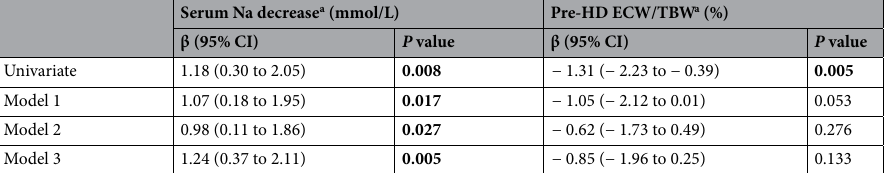
Table 3. Association of serum Na decrease (mmol/L) and pre-HD ECW/TBW (%) with SBP decrease index (%) in mixed linear regression. Model 1 is adjusted for: K decrease, urea decrease, pre-HD glucose, age, square of age, gender, ethnicity, BMI, diabetes, antihypertensive medication, coronary artery disease and congestive heart failure. Model 2 is adjusted for same variables as model 1 as well as: serum albumin, presence of AVF and dialysis vintage. Model 3 is adjusted for same variables as model 2 as well as: dialysate calcium, dialysate temperature, UFR, session time and Kt/V. Na sodium, HD haemodialysis, ECW extracellular water, TBW total body water, SBP systolic blood pressure, K potassium, BMI body mass index, AVF arteriovenous fistula, UFR ultrafiltration rate. a Standardized to a mean of 0 and a SD of 1. Bold values correspond to p <